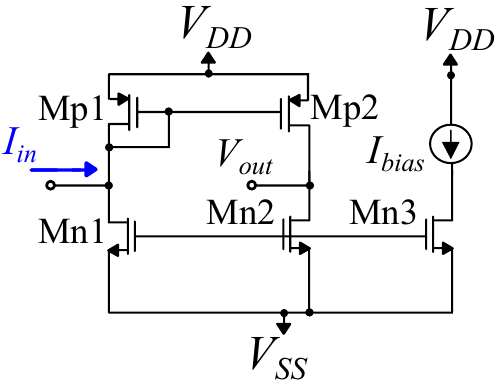
Figure 11. Transistor level implementation of a current to voltage (I-V) converter. The absoluter derives the absolute value of the difference between the input current and the current setting the Gaussian mean value by using both PMOS and NMOS current mirrors. The squaring circuits are typically translinear multipliers (using the same input twice) [35,36]. The multiplication is performed by the translinear loop; the product of currents flowing in clockwise elements is equal to the product of currents of counter clockwise elements with exponential characteristic. Some squaring circuits include an absoluter and some other ones require an external one. Also, some of them include a divider (squarer divider circuit). The exponentiator is generally based on the exponential current to voltage law of a single MOS transistor operating in the sub-threshold